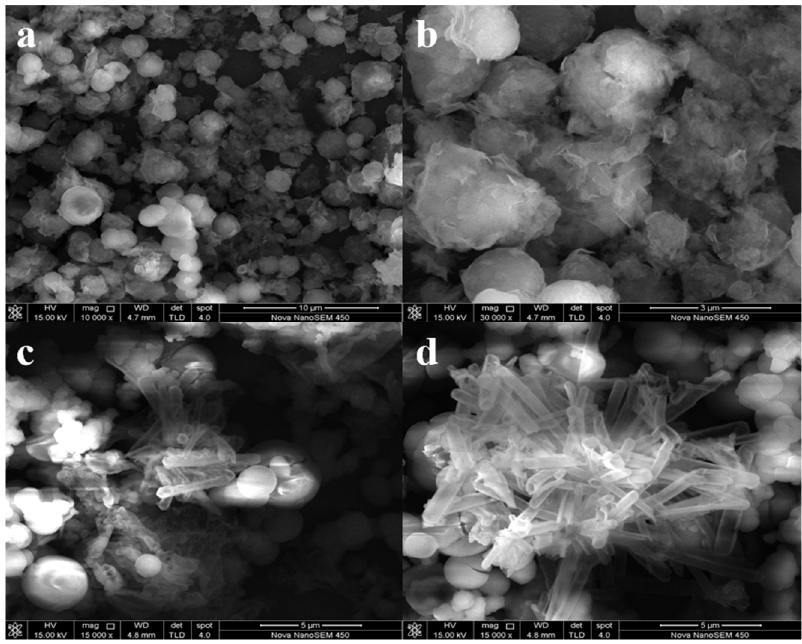
Figure 4. SEM of g-C 3 N 4 and CB-3: ( a , b ) g-C 3 N 4 , ( c , d ) CB-3.